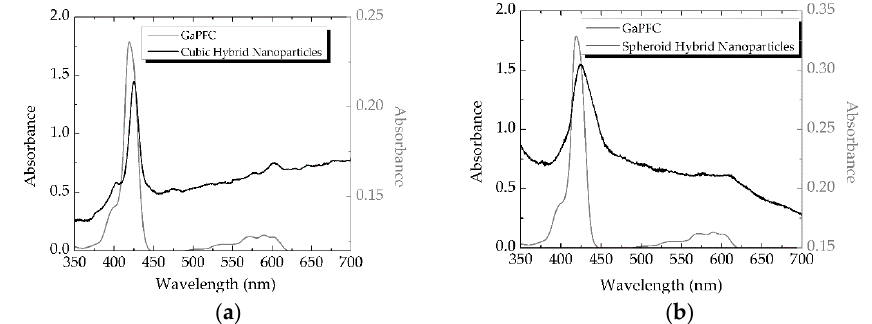
Figure 2. UV-VIS spectra in ethanol of ( a ) cuboid hybrid nanoparticles and ( b ) spheroid hybrid nanoparticles and respective corrole precursor.